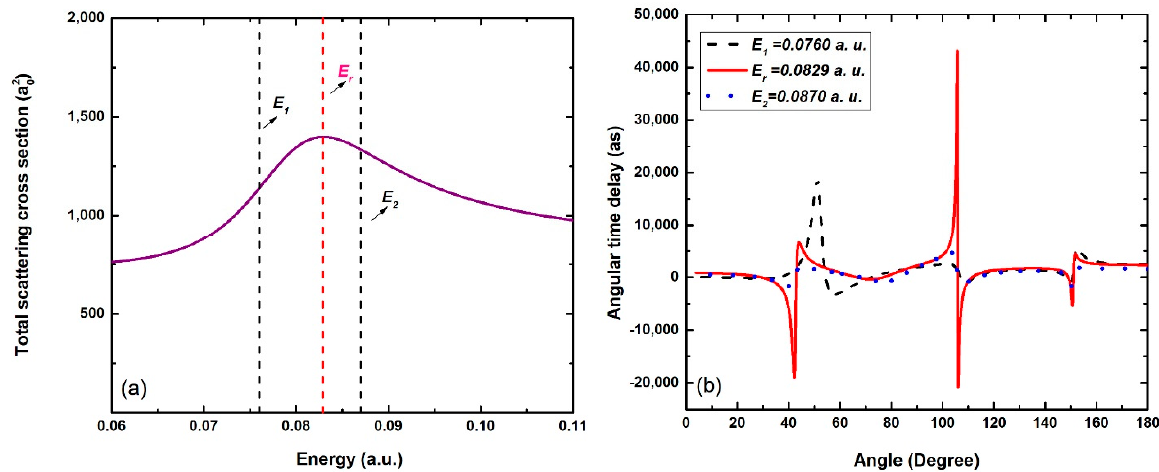
Figure 9. ( a ) Total cross-section near (cid:96) = 4 resonance and ( b ) angular time delay plotted for energies E 1 = 0.0760 a.u. (black dashed line), E r = 0.0829 a.u. (red solid line), and E 2 = 0.0870 a.u. (blue dotted line). 4 = was the